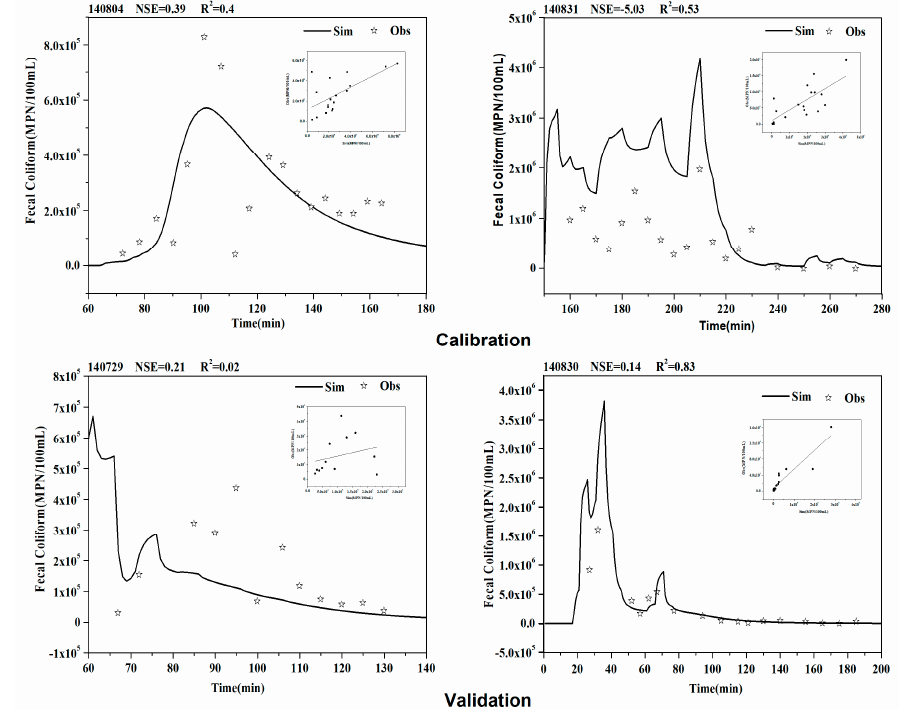
Figure 4. Calibration and validation results for MOPUS_S.